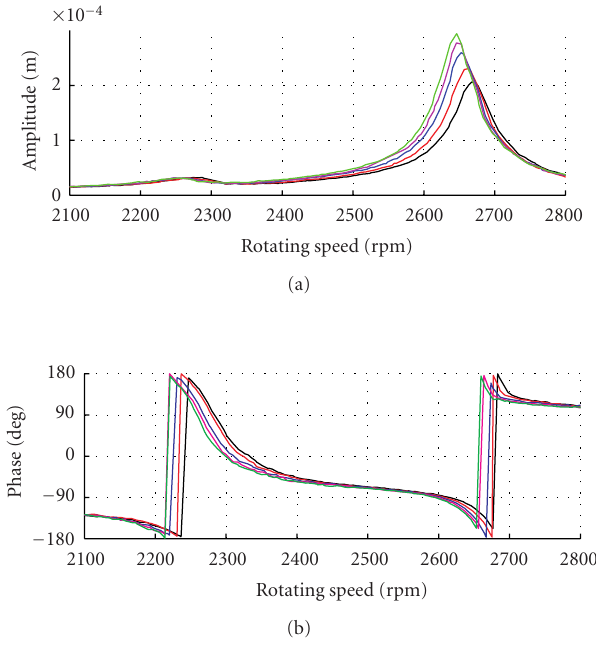
Figure 12: Unbalance responses of the 1st order during run-up for various bearing temperatures at the support B1 (black line = 30 ◦ C; red line = 35 ◦ C; blue line = 38 ◦ C; magenta line = 40 ◦ C; green line = 42 ◦ C).